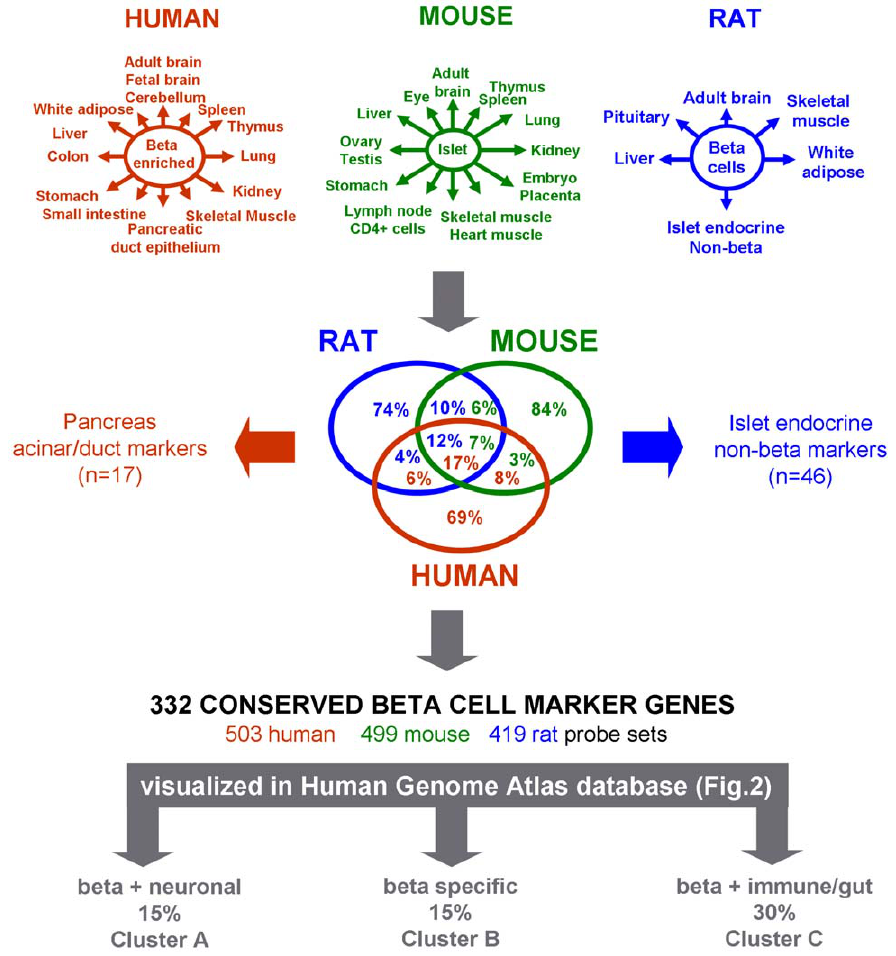
Figure 1. Selection algorithm of conserved beta cell marker genes. Beta cell preparations were compared to the indicated tissues in mouse, rat and human and genes with conserved beta cell-abundant expression selected (Venn diagram intersect). The rat data set was used to discard 46 islet endocrine non-beta cell (mainly alpha cell) markers; the human data set enabled curation of 17 pancreatic exocrine (acinar and duct) markers. Final set of conserved beta cell marker genes consists of 332 genes, represented by 419 (rat), 499 (mouse) or 503 (human) oligonucleotide probe sets.